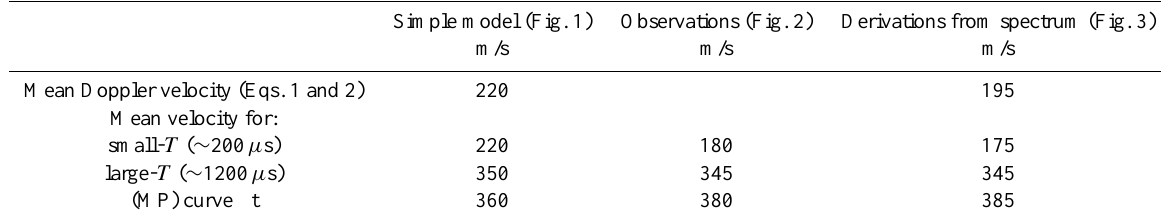
Table 1. Observed and estimated (numerical)